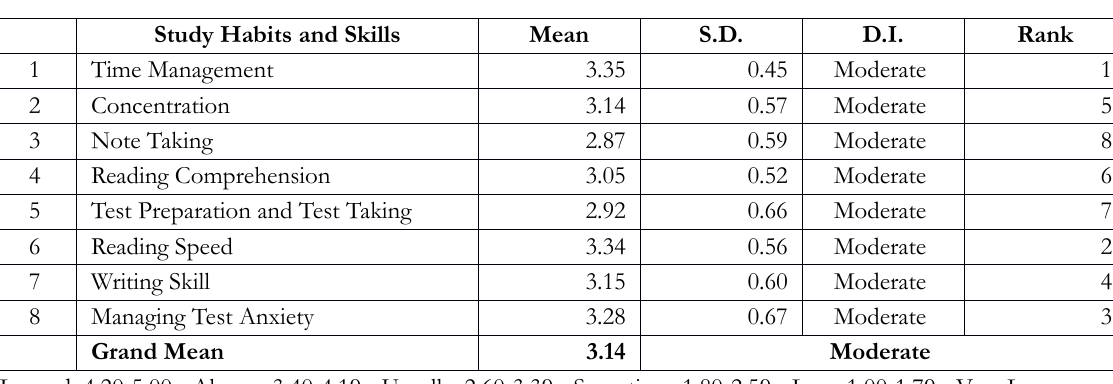
Table 2. Study habits and Habits of the